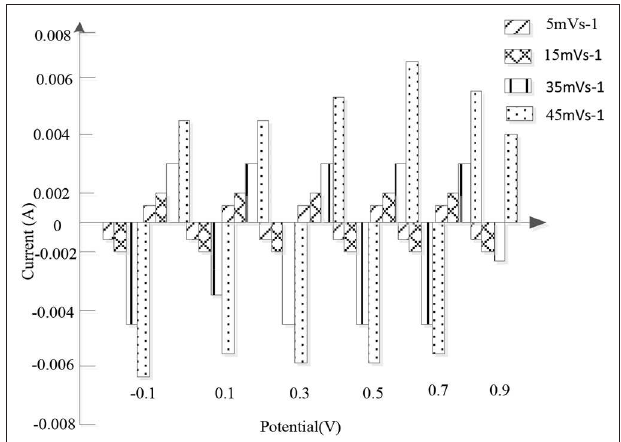
FIGURE 7 | The current state diagram of nitrogen-deposited porous carbon at a potential of − 0.1–0.9v in 1M sulfuric